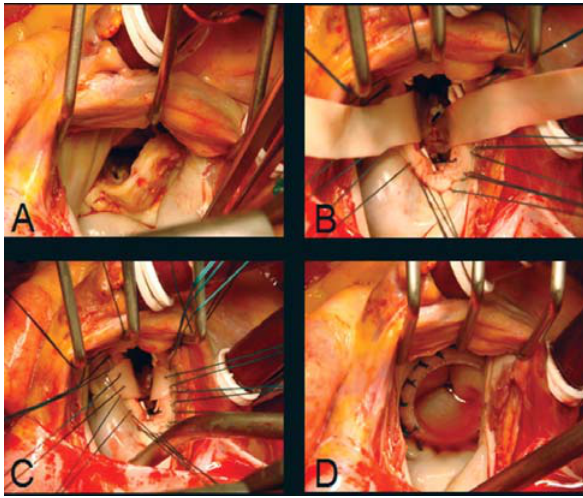
Fig. 2 – (A) Intensa calcificação da valva mitral; (B) fitas de PB cruzadas afixadas ao topo dos músculos papilares; (C) Fixação das fitas de PB ao anel mitral; (D) Prótese mitral implantada